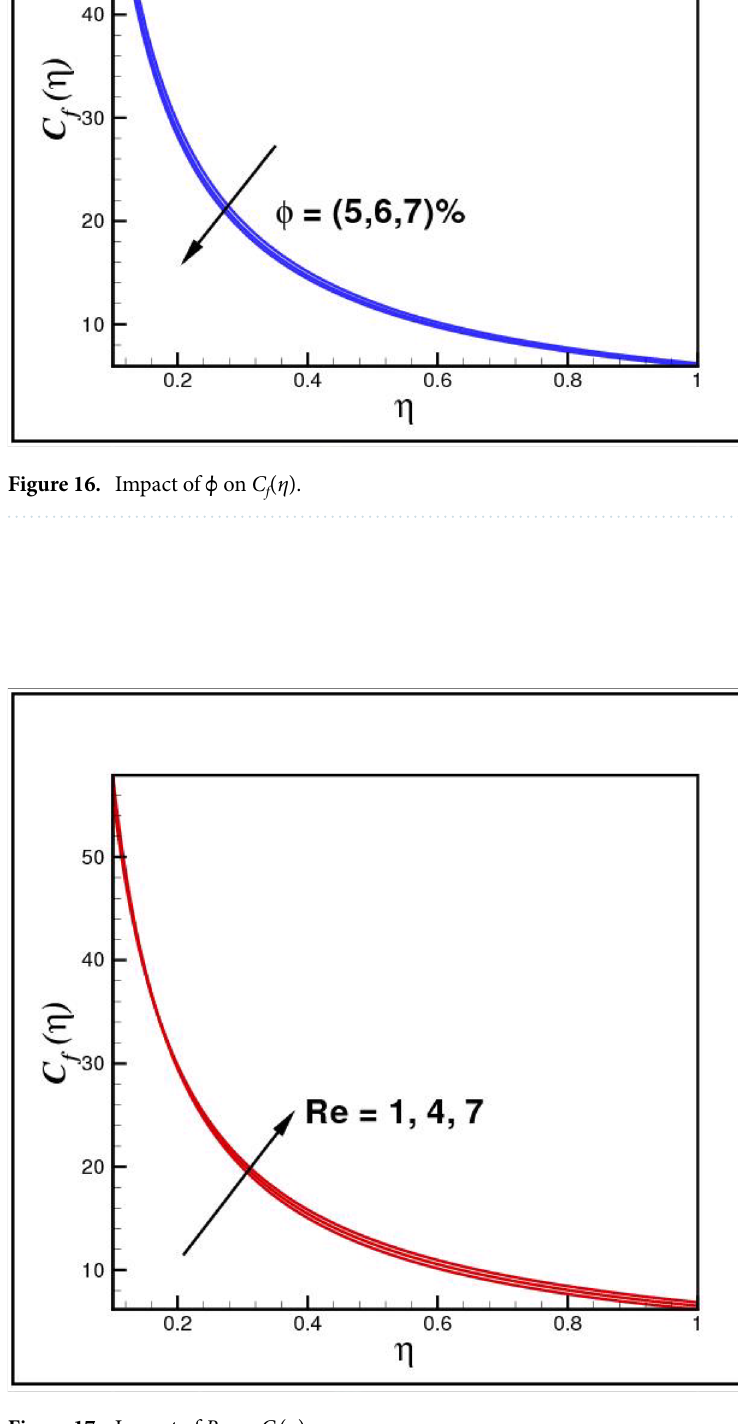
Figure 17. Impact of Re on C f ( η